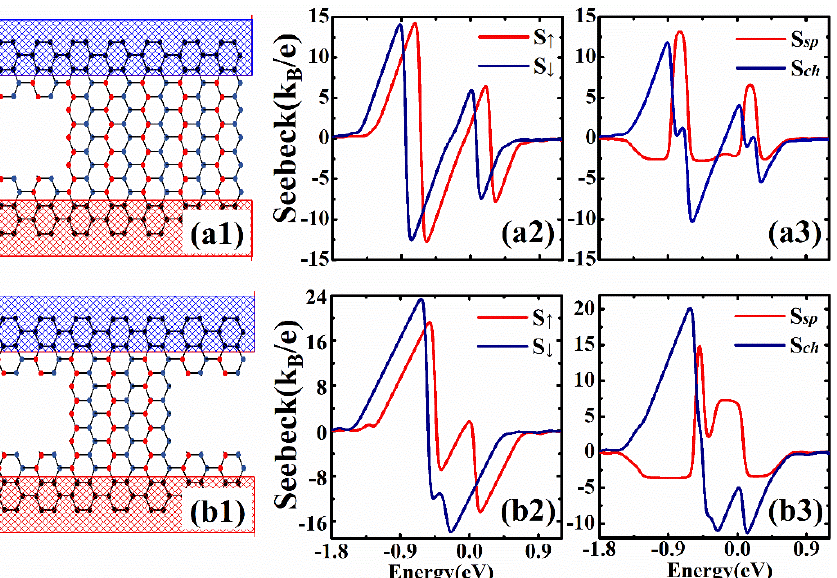
Figure 5. Spin-dependent Seebeck coefficients for the device with notches on the edges of the ribbon. ( a1 – a3 ) The schematic illustration and spin-dependent Seebeck coefficients for the device with one asymmetric square notch on the ribbon edge. ( b1 – b3 ) The schematic illustration and spin-dependent Seebeck coefficients for the device with two square notches on the two ribbon edges. The other parameters for the device are: exchange splitting M = 0.184 eV and temperature k B T = 0.03 | t 1 | .